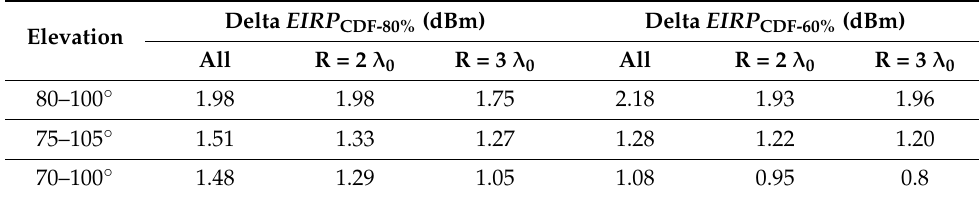
Figure 13. EIRP CDFs comparison within 80 ◦ to 100 ◦ . Table 3. Summarization of CDFs